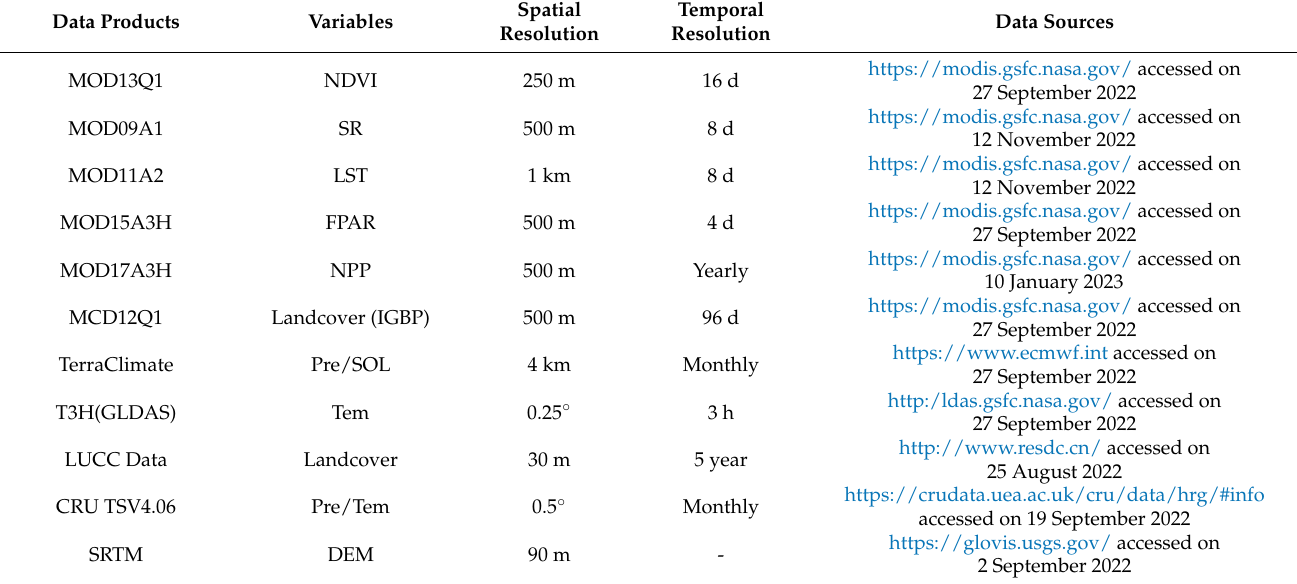
Table 1. Data product types and